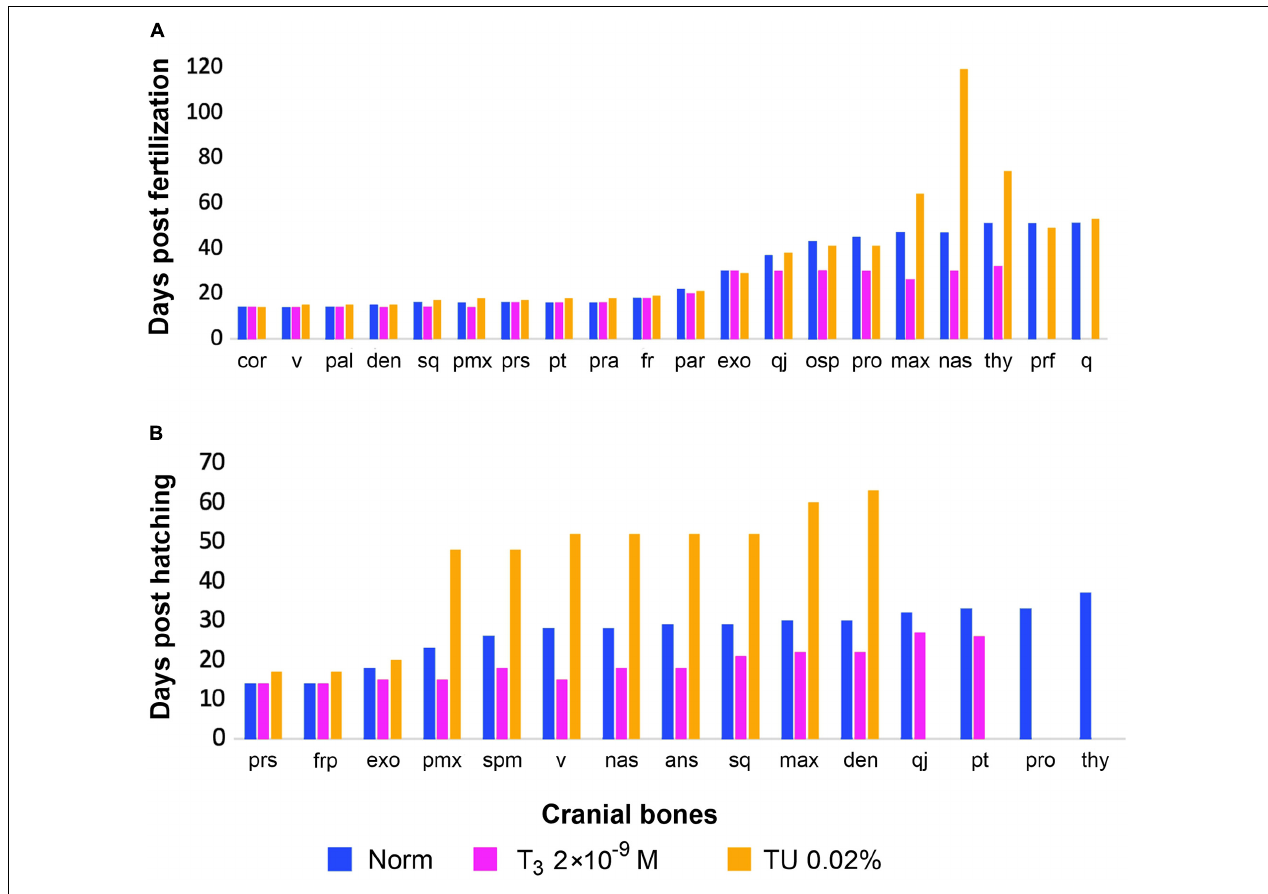
FIGURE 8 | Timing of cranial bones development (earliest appearance) under same experimental hormonal regimes (in norm, under T 3 and TU-treatment), (A) in Pleurodeles waltl (after Smirnov et al., 2020) and (B) in Bombina variegata (this study). Abbreviations: cor, coronoid; den, dentary; exo, exoccipital; fr, frontal; max, maxilla; nas, nasal; osp, orbitosphenoid; pal, palatine; par, parietal; pmx, premaxilla; pra, prearticular; prf, prefrontal; pro, prootic; prs, parasphenoid; pt, pterygoid; q, quadrate; qj, quadratojugal; sq, squamosal; thy, os thyroideum; v,